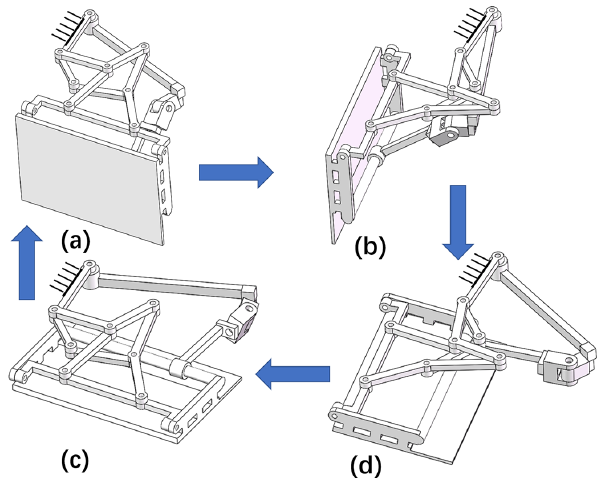
Figure 9. Demonstration of a swimming cycle using the spatial